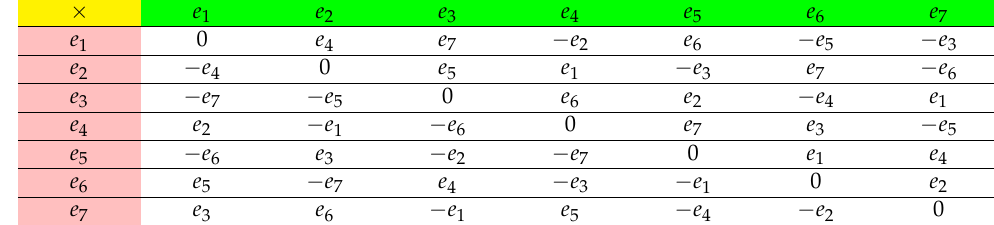
Table 1. Multiplication rule for the cross product in R 7